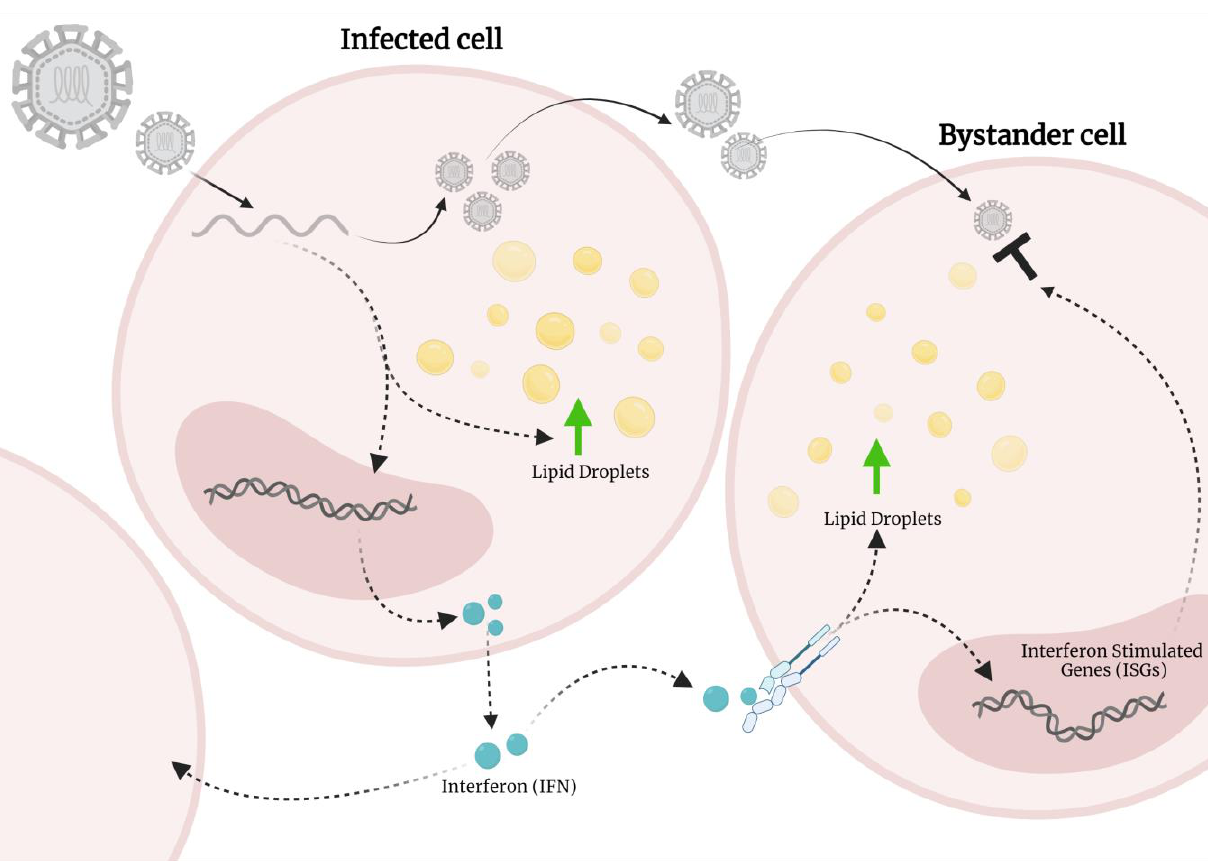
FIGURE 1: Lipid droplets upregulated by IFN may contribute to a bystander effect. Viral infection of a cell leads to the increase of lipid droplets (LDs) and the production of interferon. Interferon is secreted out of cells where it sets up a bystander effect in neighbouring unin- fected cells. This interferon also activated the accumulation of LDs, which we hypothesis could contribute to this phenomenon. Figure cre- ated on